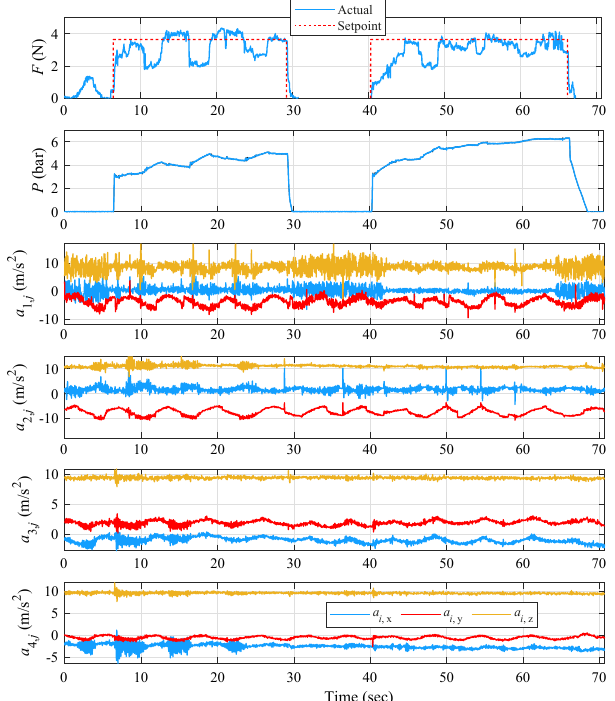
Figure 17. Experimental evaluation of iteration (B) and the effect of applying resisting force on the ET-diagnosed volunteer’s metacarpal region under closed-loop reference in applied pressure, while performing finger-bending motions that finish with touching a spherical object; Exp.